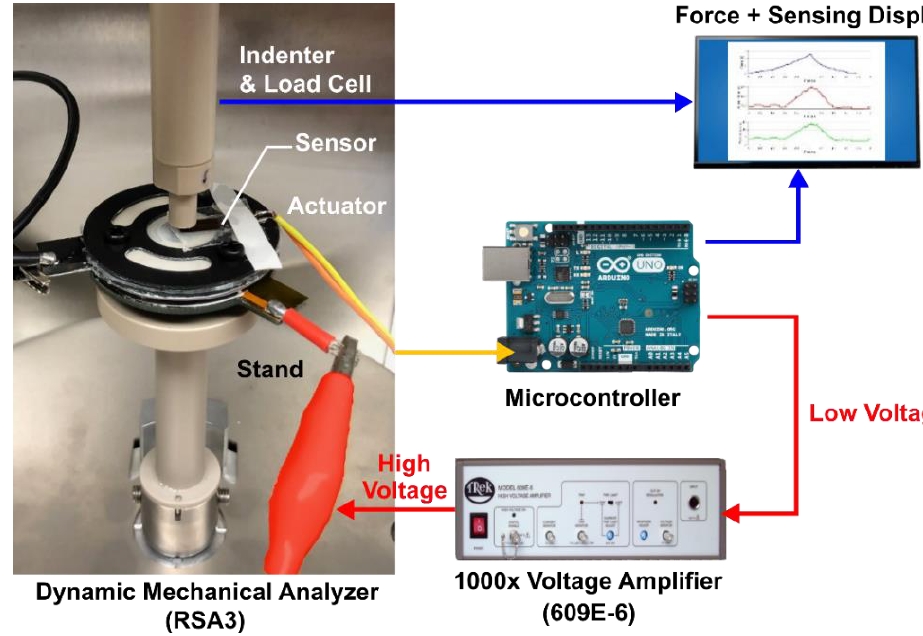
Figure 8. Experimental setup for dynamically evaluating the haptic module.